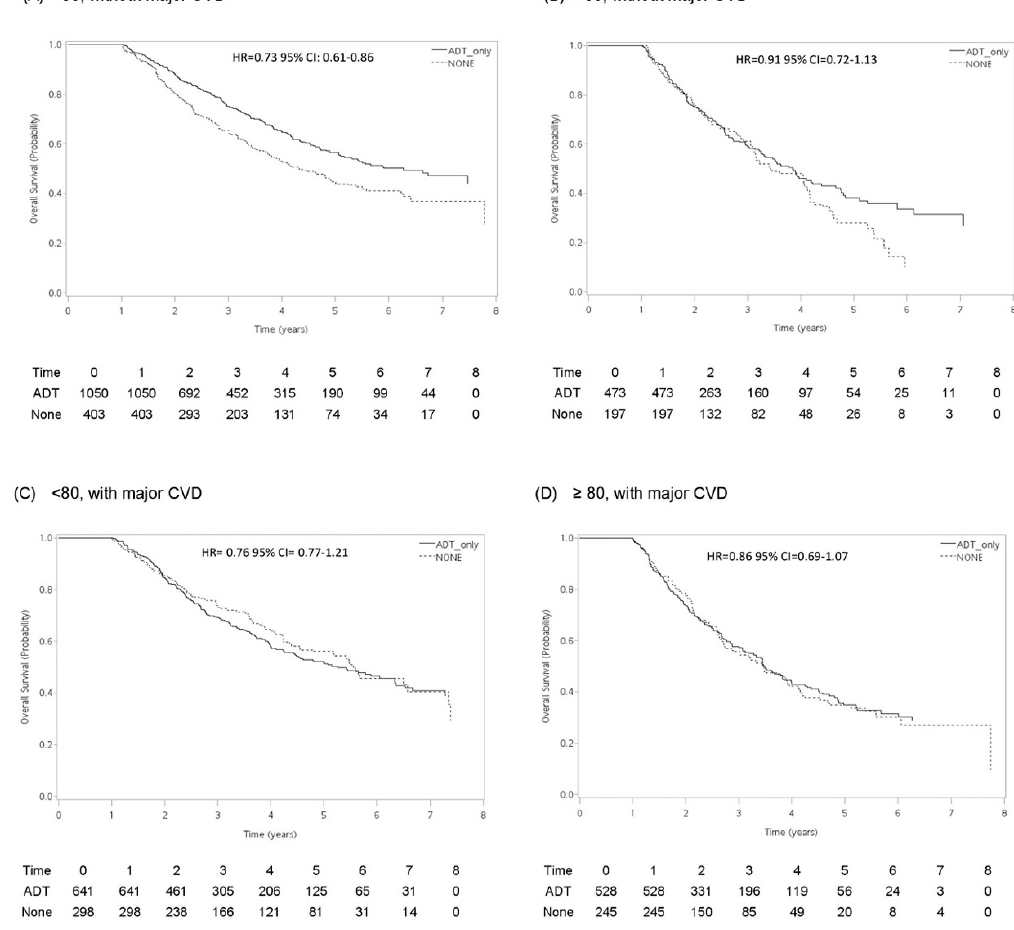
Figure 1. Inversed probability weighted survival estimates for all-cause mortality in men with metastatic prostate cancer receiving androgen deprivation therapy vs. watchful waiting by age group and the status of baseline cardiovascular comorbidities (major cardiovascular diseases): ( A ) < 80 years old without major cardiovascular diseases, ( B ) ≥ 80 years old without major cardiovascular diseases, ( C ) < 80 years old with major cardiovascular diseases, and ( D ) ≥ 80 with major cardiovascular diseases.